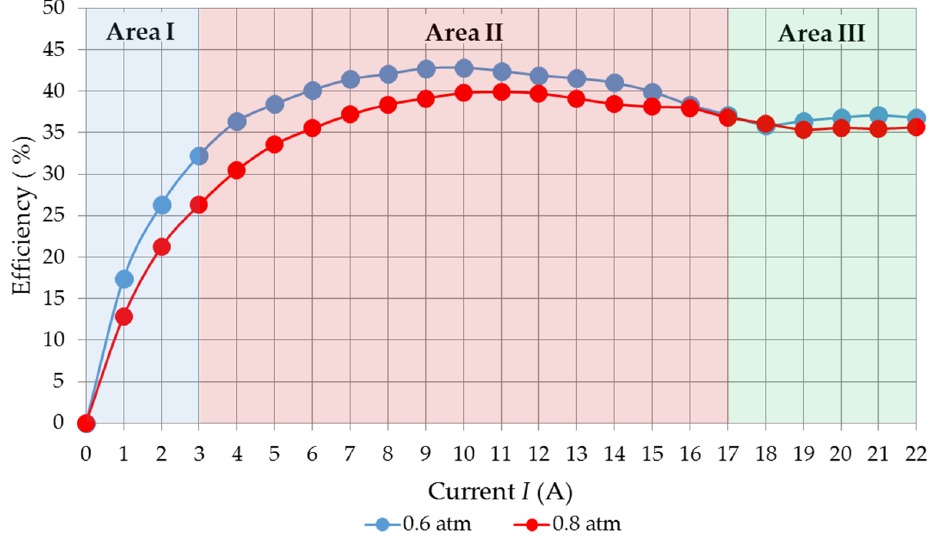
Figure 11. Dependence of η PEMFC on load current at p = 0.6 atm (blue line) and 0.8 atm (red line).